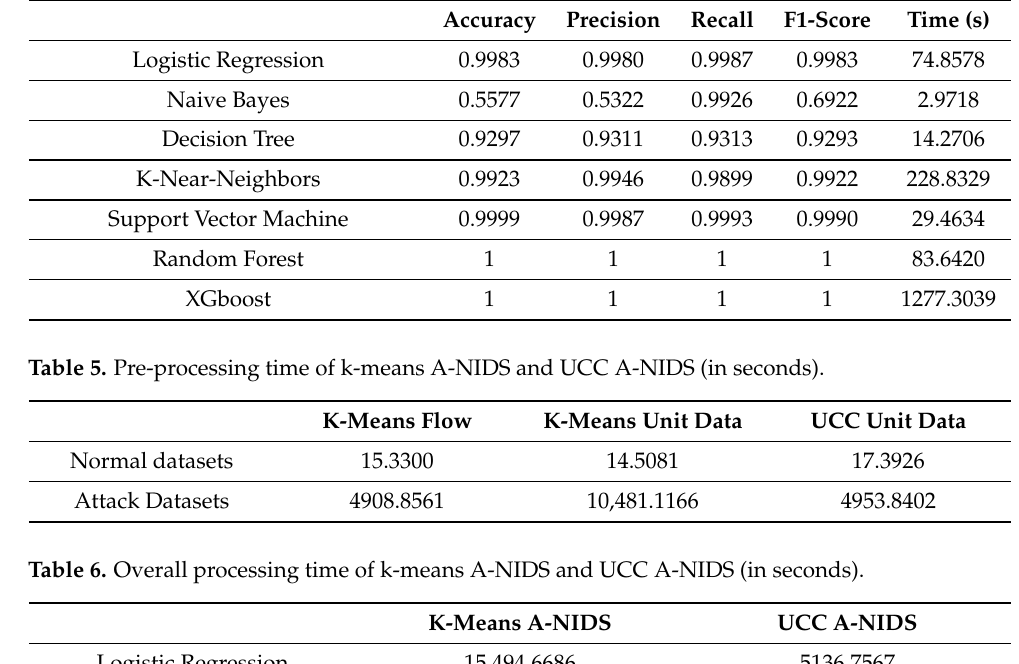
Table 4. Result of k-means A-NIDS detection.